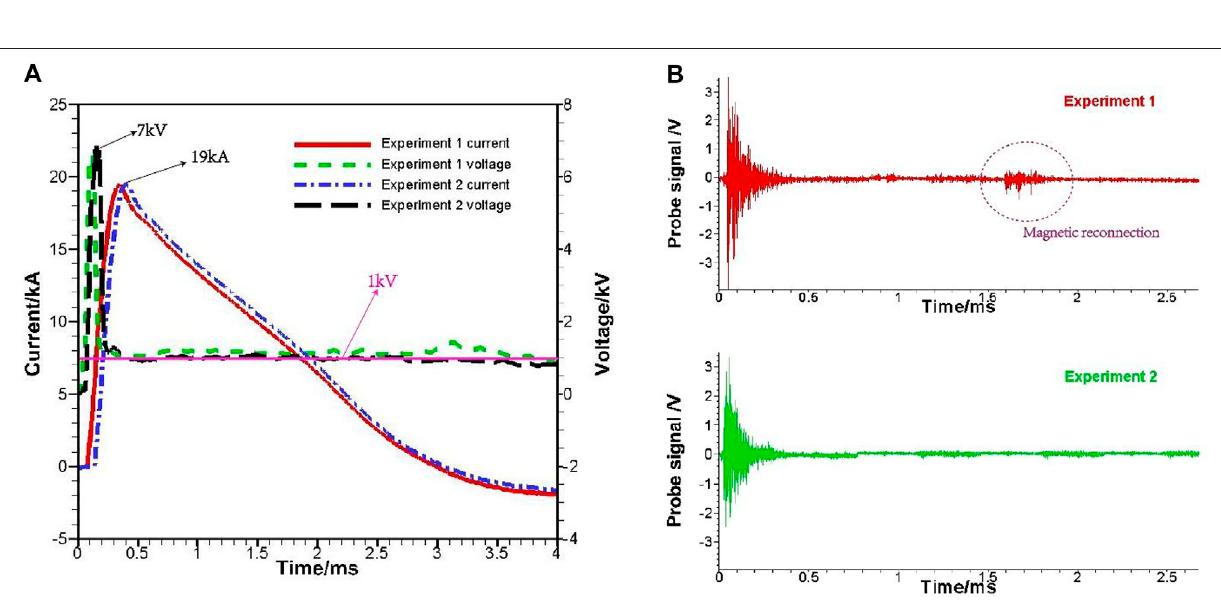
Frontiers in Physics |